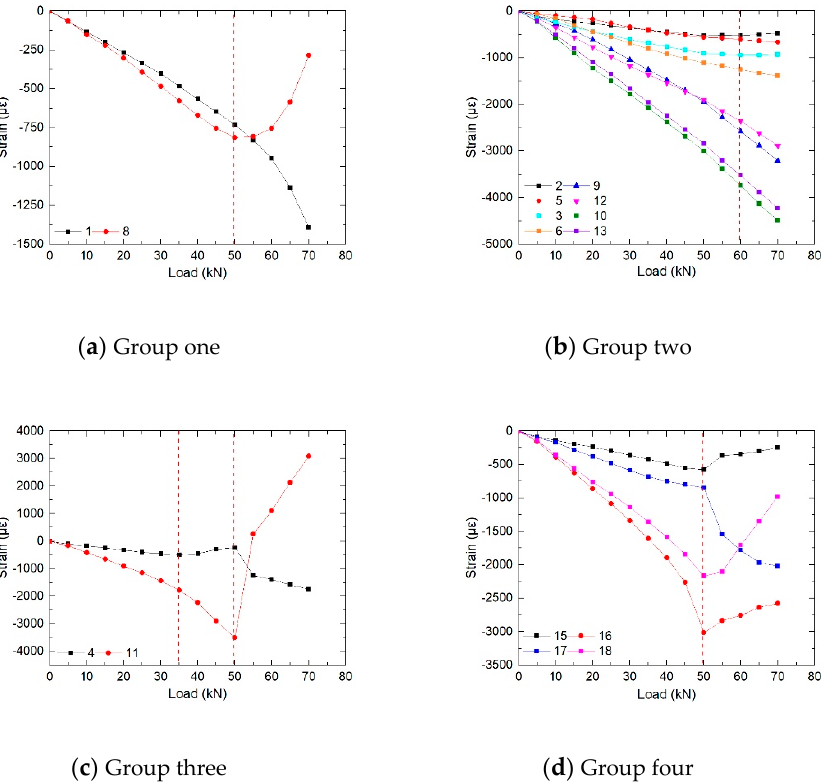
Figure 7. Typical strain-load curves of the third compressive sample with defective diameter 80 mm (CD80-3).